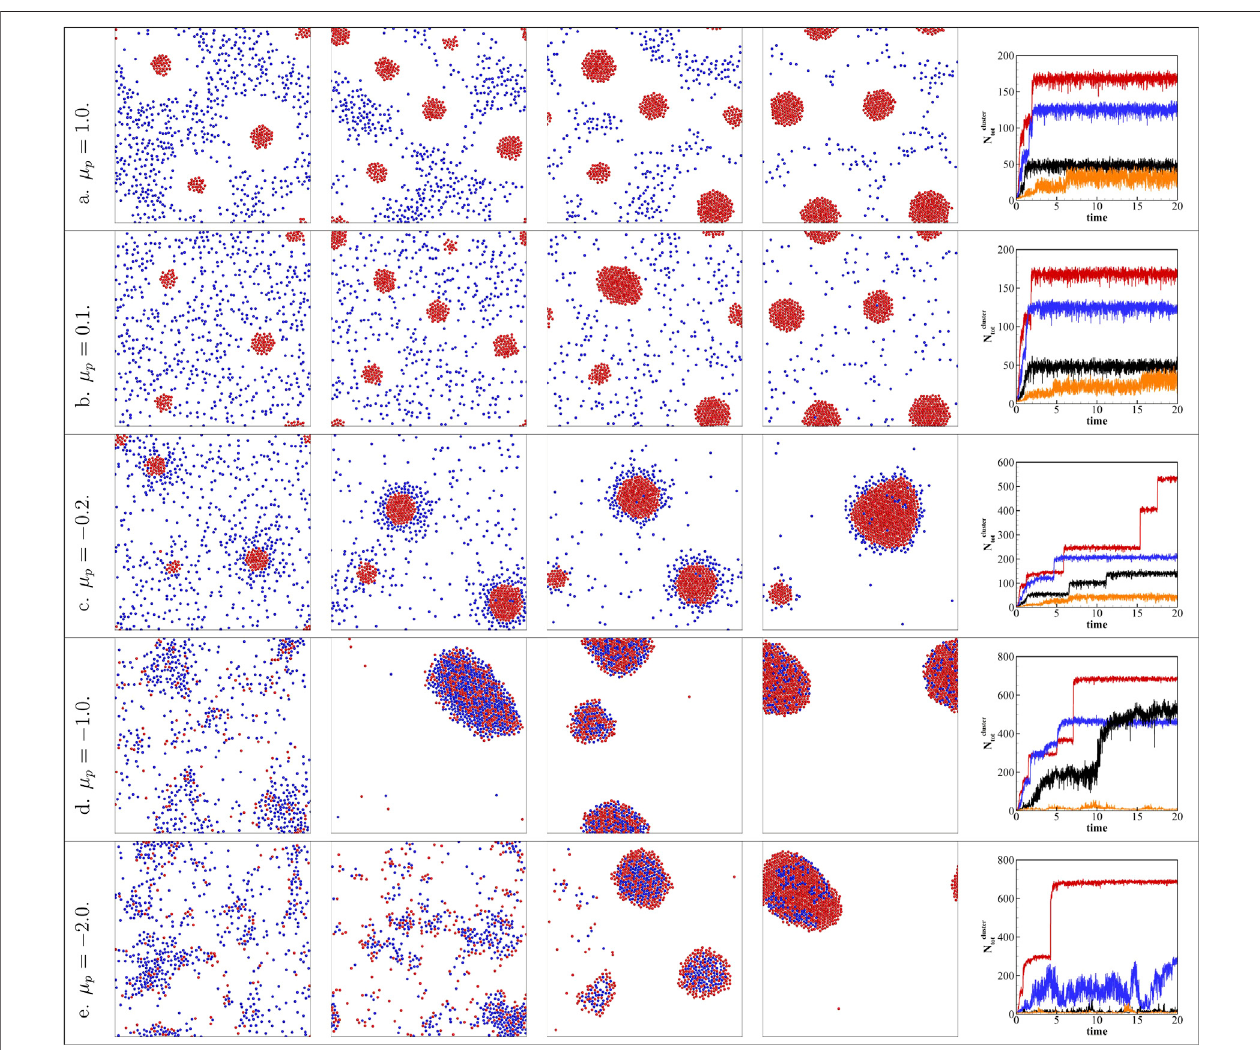
FIGURE 3 | Keeping the total area fraction ϕ tot = 10 % , increasing ϕ a = 2 % to ϕ a = 8 % with different passive colloid surface mobilities ~ μ p varies from 1.0 to − 2.0. (A) ~ μ p (cid:1) 1 . 0, (B) ~ μ p (cid:1) 0 . 1, (C) ~ μ p (cid:1) − 0 . 2, (D) ~ μ p (cid:1) − 1 . 0, (E) ~ μ p (cid:1) − 2 . 0.Theareafractionsofeachspeciesofcolloidsarespeci fi cally ϕ a =2 % , ϕ p =8 % ; ϕ a =4 % , ϕ p =6 % ; ϕ a = 6 % , ϕ p = 4 % ; and ϕ a = 8 % , ϕ p = 2 % from left to right. The fi fth column shows the time evolution of the stoichiometry of the biggest cluster arising from aggregation mixtures. ϕ p = 2 % is red, ϕ p = 4 % is blue, ϕ p = 6 % is black, and ϕ p = 8 % is